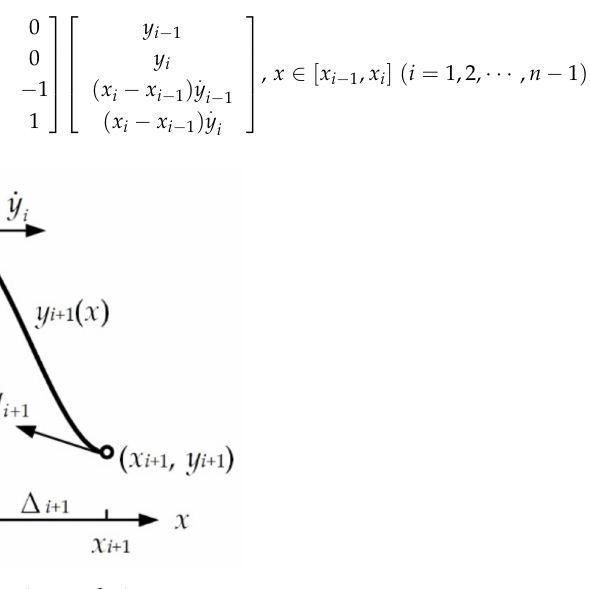
Figure 6. Piecewise cubic Hermite interpolation